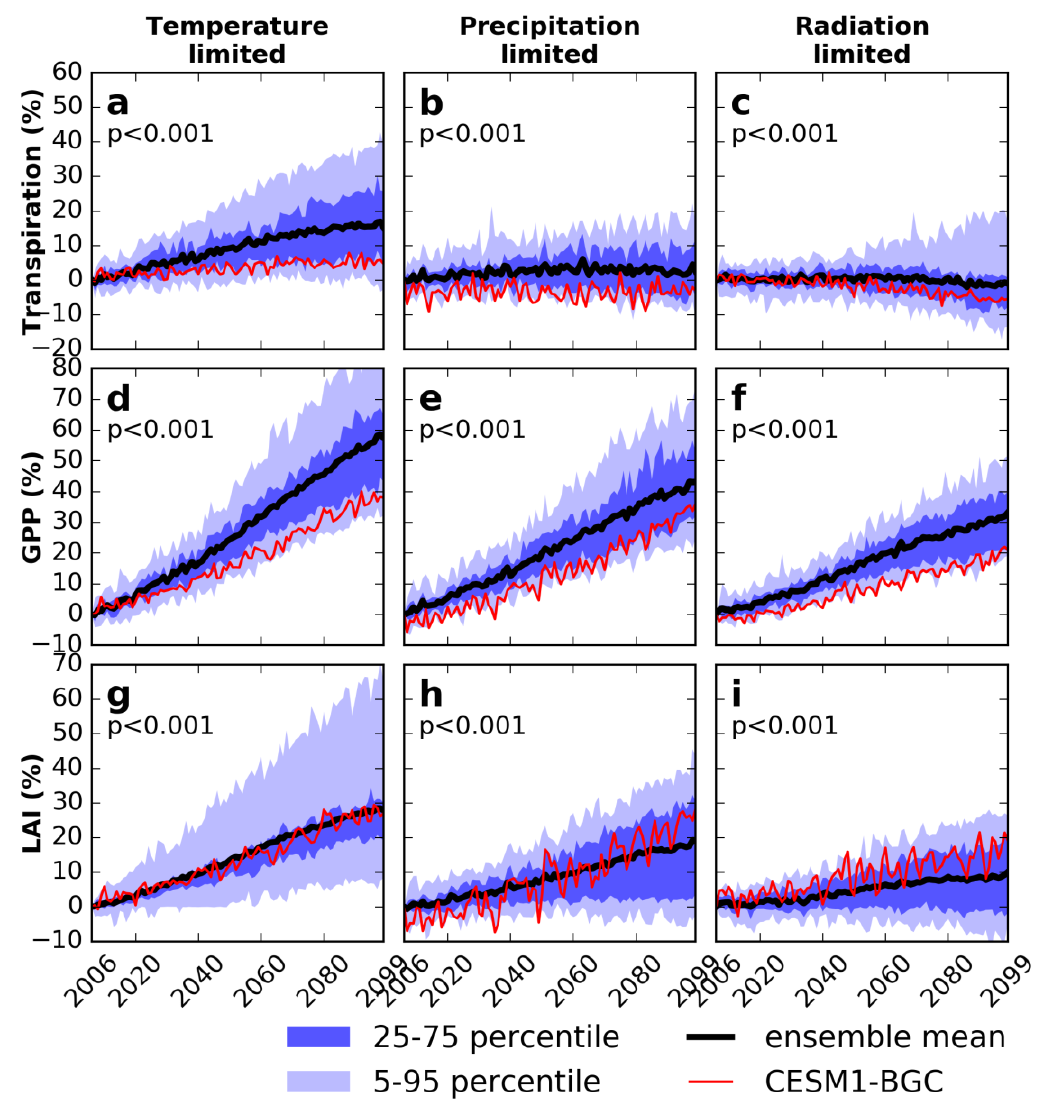
Figure 4. Vegetation responses from the Earth system models of CMIP5, summarized over the three climate-limiting regions. Same as Figure 3, except for changes in transpiration ( a – c ), GPP ( d – f ), and LAI ( g – i ).